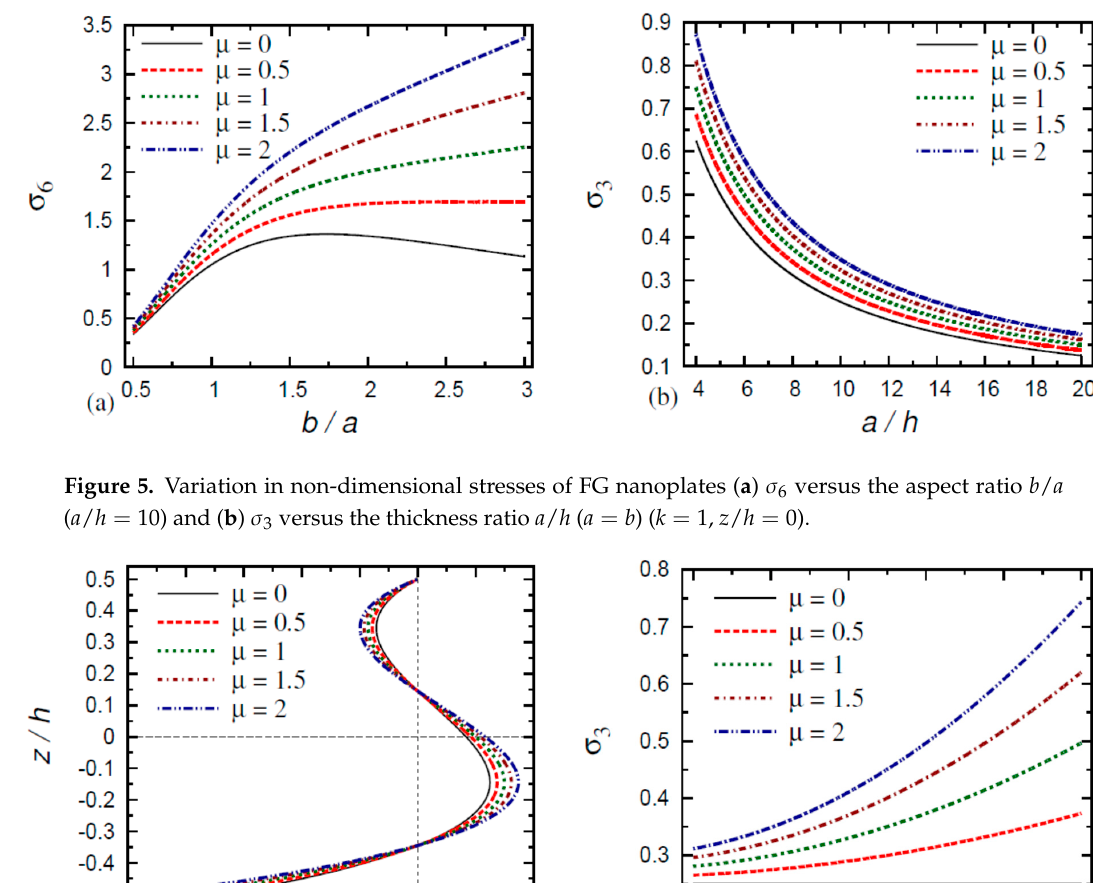
Figure 4. Variation in non-dimensional displacements (cid:1875)(cid:3365) of FG nanoplates, (cid:1853)/ℎ = 10 , (cid:1878)/ℎ = 0 ( a ) versus the aspect ratio (cid:1854)/(cid:1853) ( (cid:1863) = 1 ) and ( b ) versus the small length scale (cid:2020) ( (cid:1853) = (cid:1854) ).